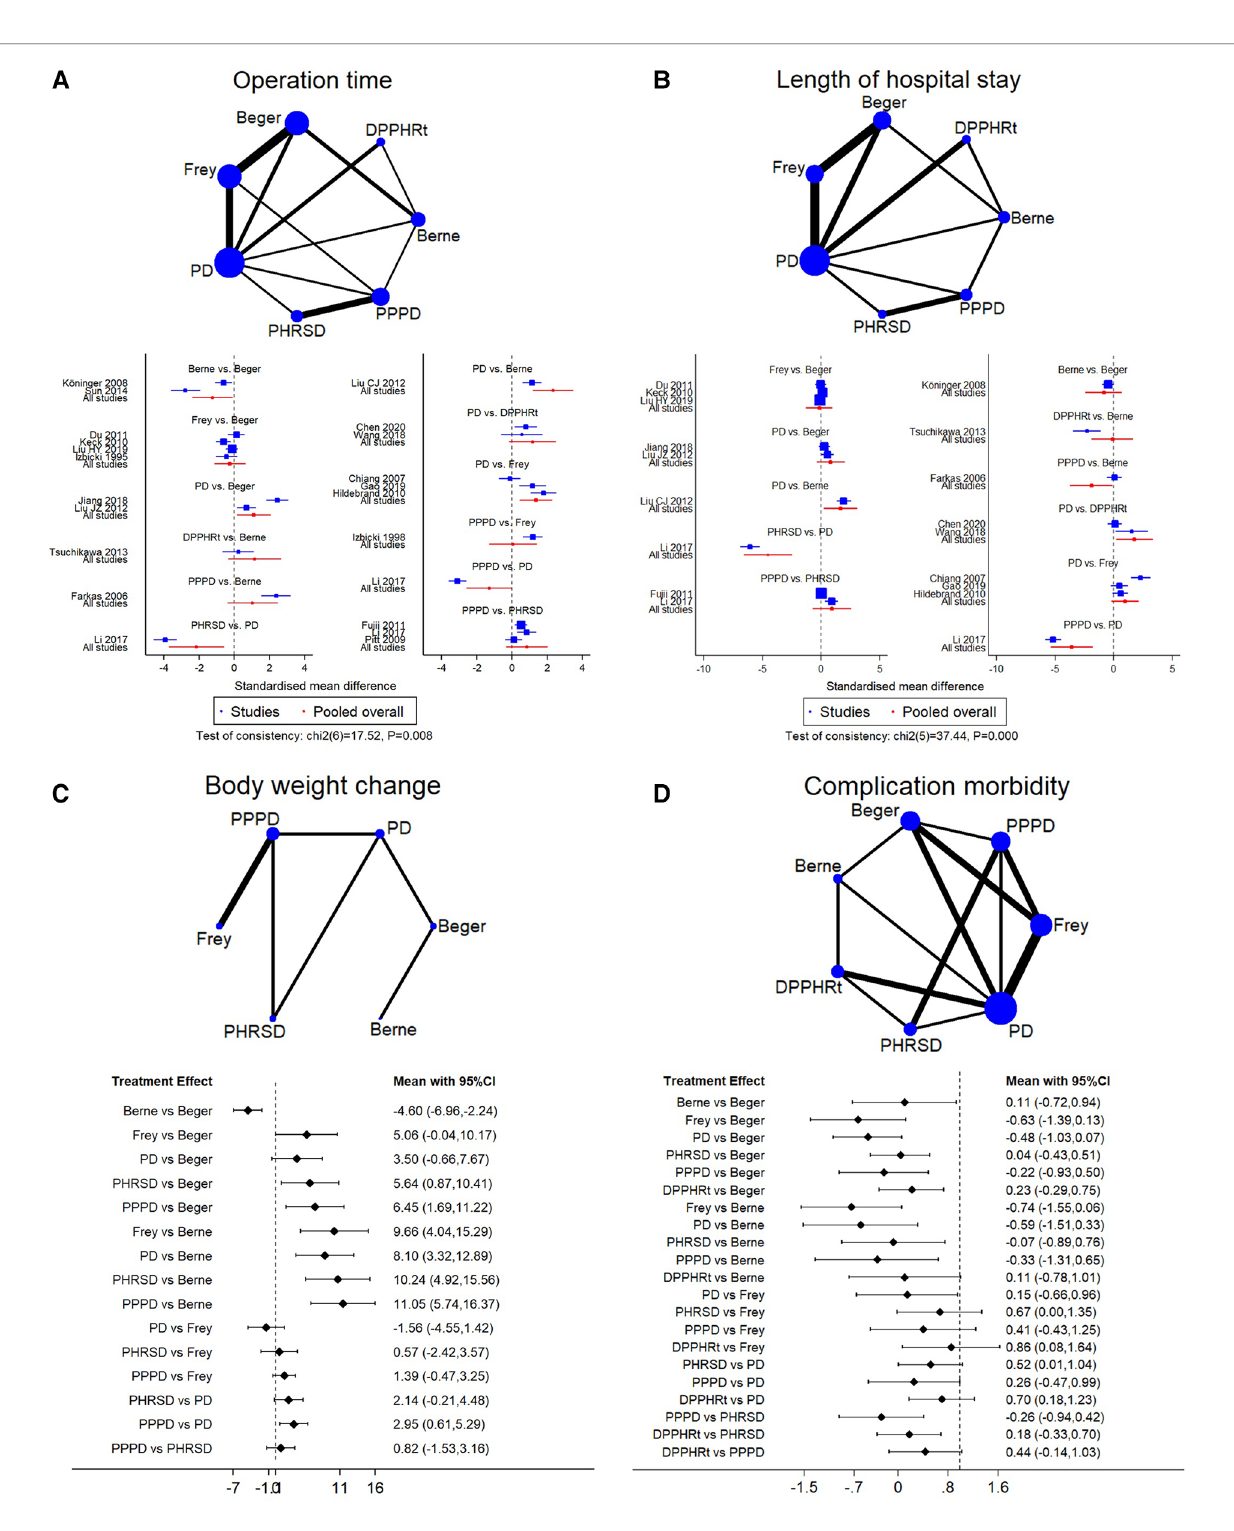
FIGURE 3 Network meta-analysis. ( A ) Operation time, ( B ) length of hospital stay, ( C ) body weight change, and ( D ) complication